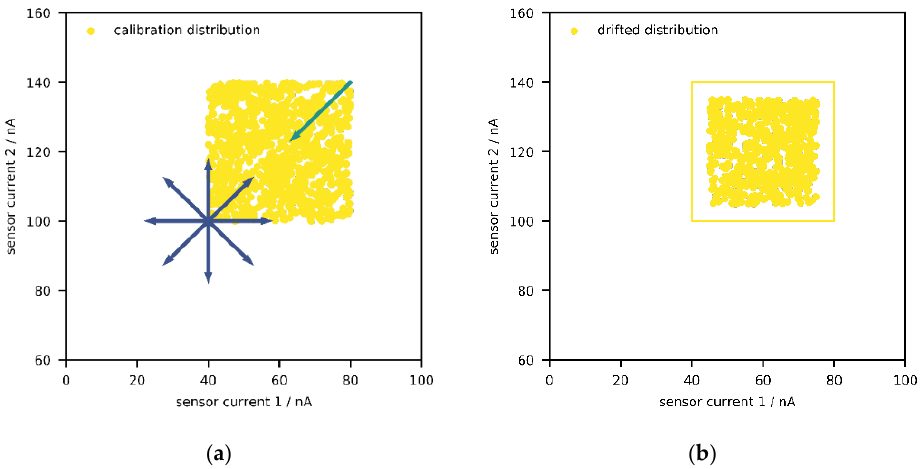
Figure 6. Distribution of sensor currents for a system consisting of two sensors. ( a ) Zero drift (blue) moves the baseline (lowest possible signal intensity) in any direction, while sensitivity drift (green) causes the maximum possible signal intensity to decay exponentially. ( b ) Example of a signal distribution that has shifted inside the envelope, thus no anomalies were detected.